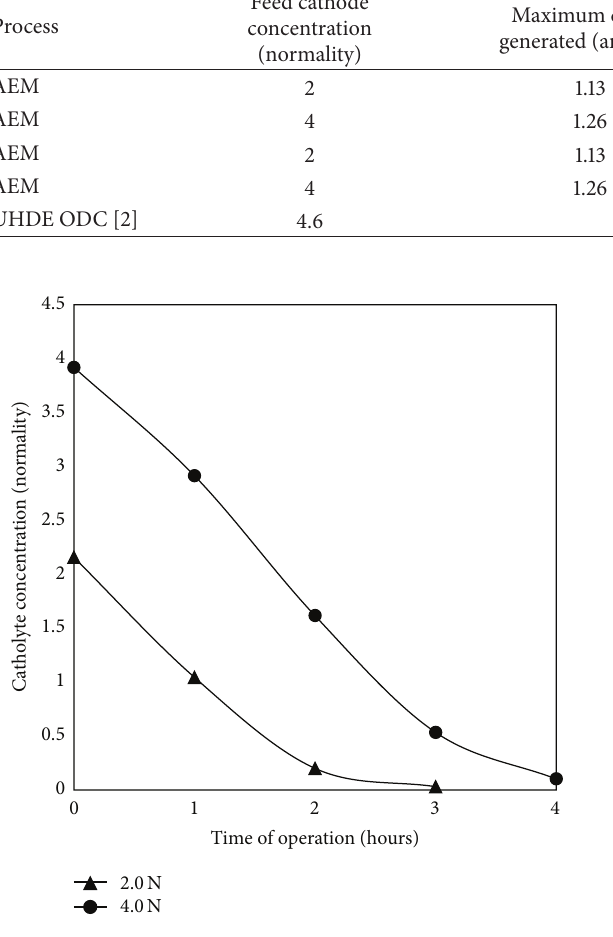
Figure 10: Catholyte concentration (normality) versus time of operation (hours) for 4N and 2 N feed concentrations.